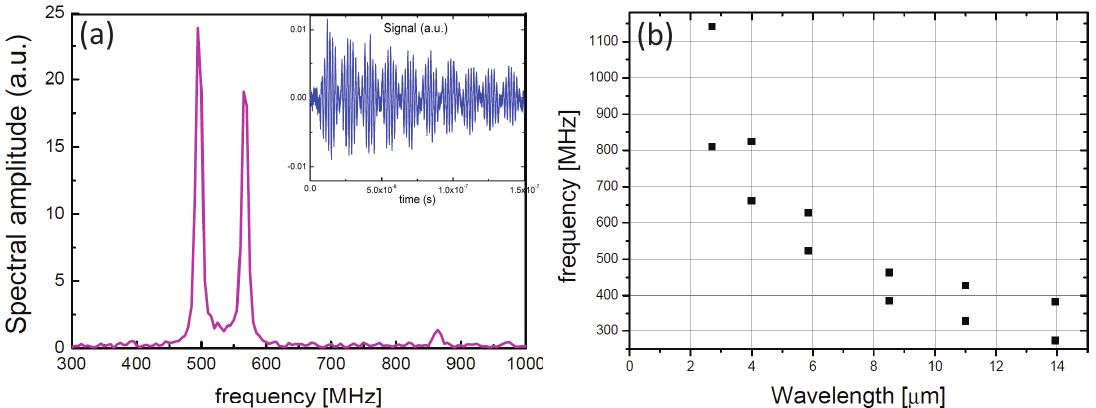
Figure 4. Typical frequency spectrum of the laser-generated signal shown in the insert TGM acquired for the SAW (surface acoustic wave) wavelength Λ = 5.85 µ m ( a ). Typical dispersion diagram obtained in experiment ( b